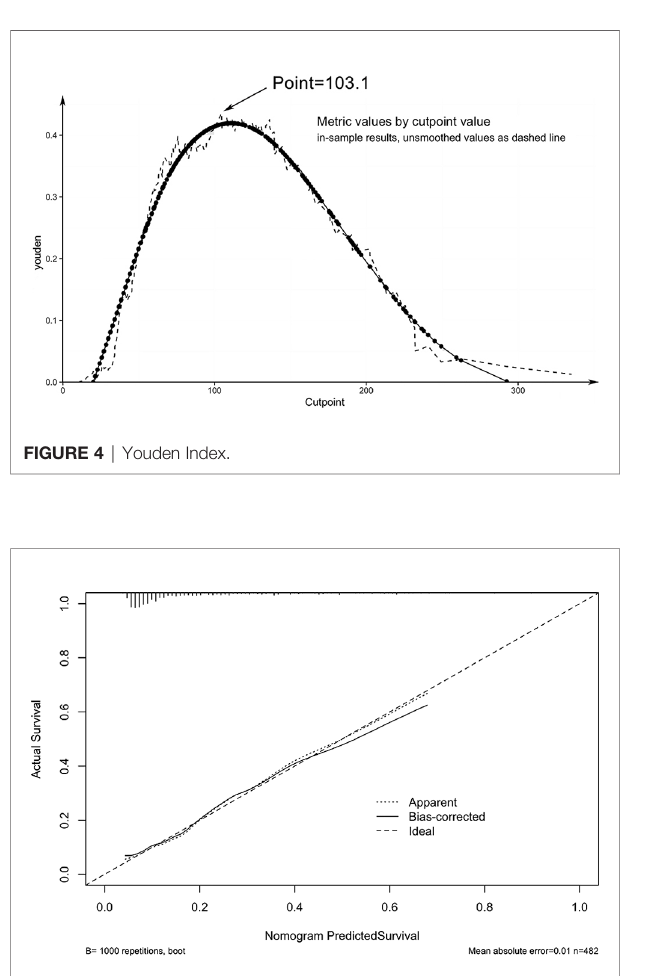
FIGURE 5 | Bootstrap Method. The x-axis shows the probability of LN- prRLN metastasis predicted by the nomogram and the y-axis shows the actual ratio of LN-prRLN metastasis. The reference line is a dashed line, indicating the apparent